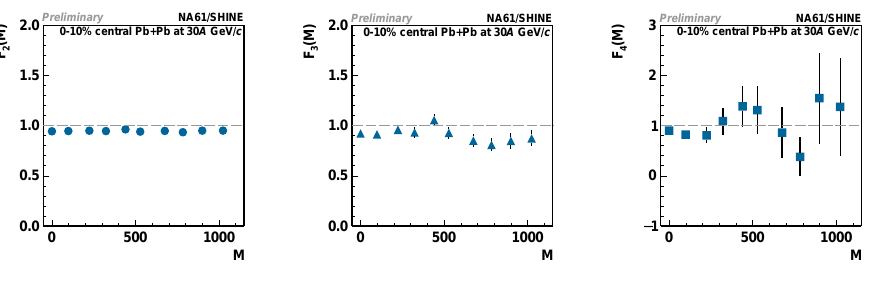
Figure 6. The dependence of the scaled factorial moments (F 2 , F 3 and F 4 ) of negatively charged particle multiplicity distribution on the number of subdivisions in cumulative transverse-momentum space M for 1 ≤ M ≤ 32 2 for central (0-10%) 208 Pb + Pb at 30 A GeV/ c collisions. The results for F 2 , F 3 and F 4 are plotted from left to right . Only statistical uncertainties are indicated.